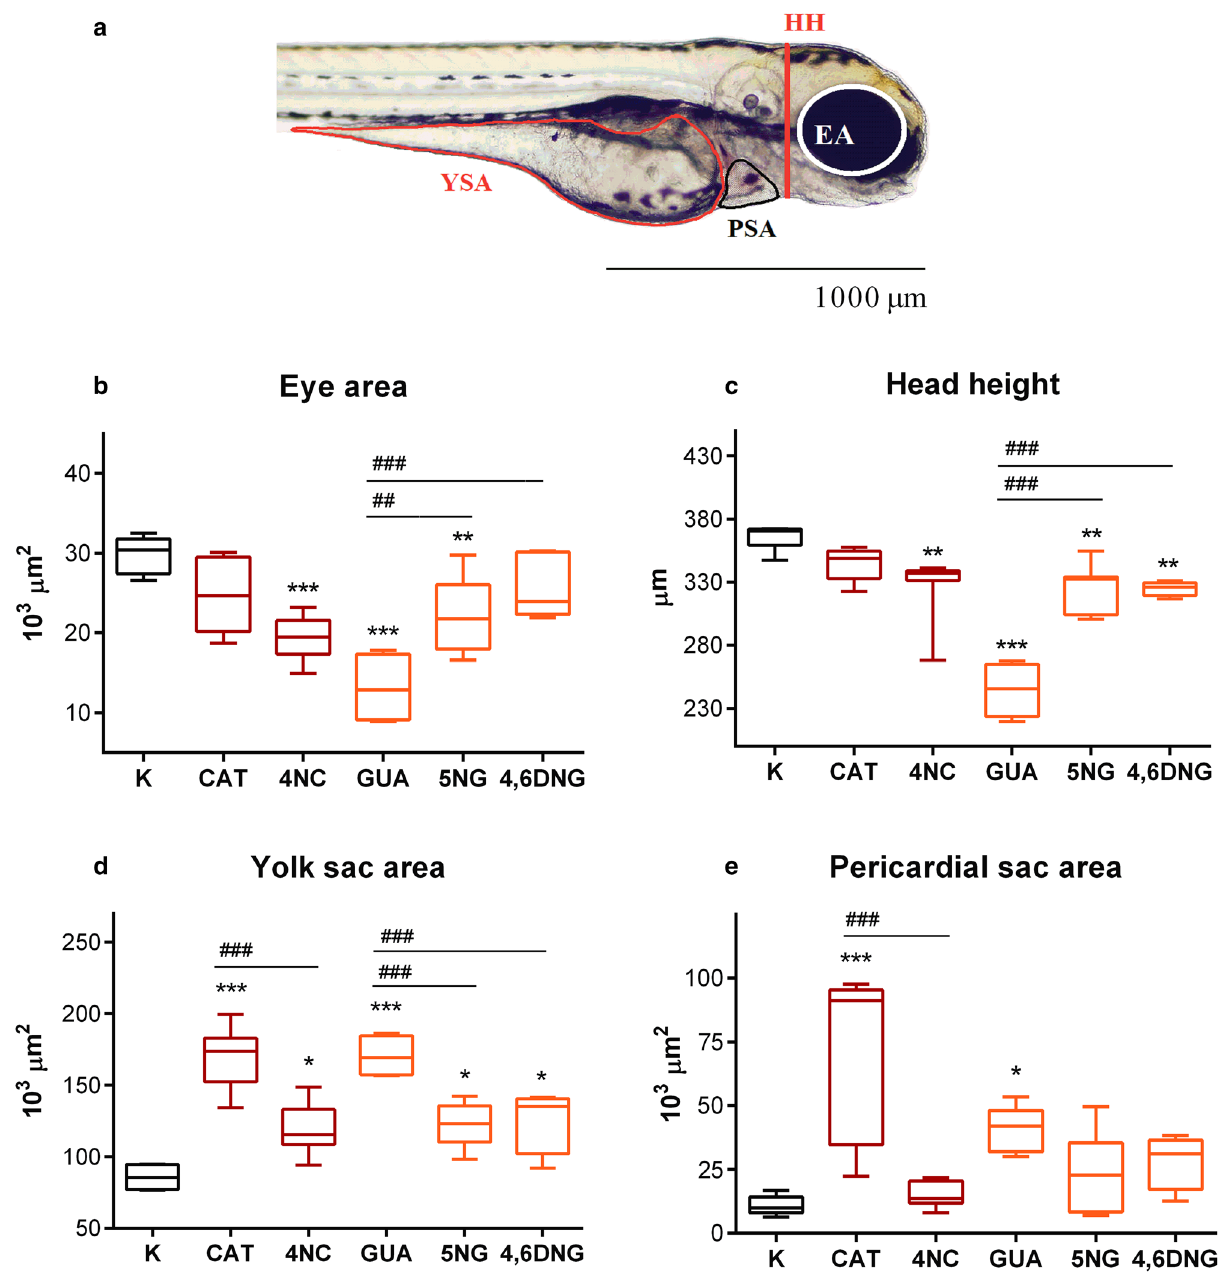
Figure 4. Morphometric measurements of D. rerio larvae after 96-h exposure to tested compounds (CAT, 4NC, GUA, 5NG, and 4,6DNG) and control (C). ( a ) Lateral view showing eye area (EA), head height (HH), yolk sac area (YSA), and pericardial sac area (PSA). Scale bar = 1000 µm. Morphometric parameters are presented by their mean value ( b – e ; n = 15). The symbol * indicates a significant difference between tested samples and negative control (*p < 0.05; **p < 0.01; ***p < 0.001). Mean values sharing common letters indicate significant differences among different tested compounds (*p < 0.05). A line within the box represents the median value, while the boundaries of box-plot indicate 25th and 75th percentiles. Whiskers above and below the box indicate 10th and 90th percentiles. Statistical analysis and data presentation were prepared using GraphPad Prism software version 6.0 (https ://graph pad-prism .softw are.infor mer.com/6.0/), while visualization and morphometric measurements were performed using Microsoft AnalySIS Soft Imaging System software (https